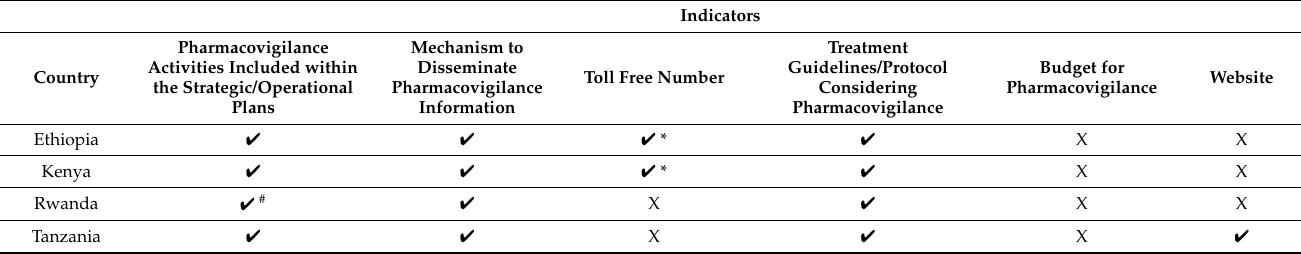
Table 1. National systems, structures, and stakeholder